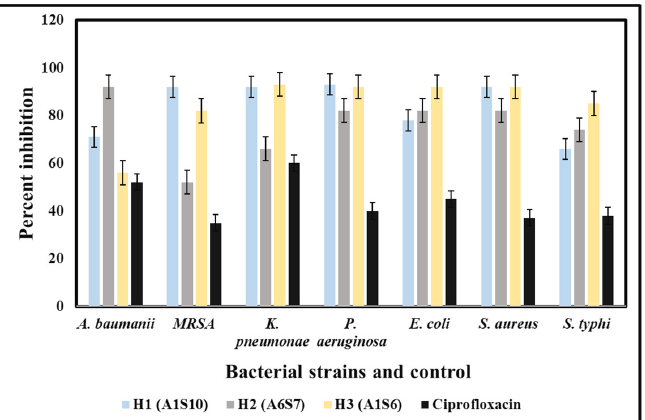
Figure 2. MIC results are shown by crude extracts of bacterial species against MDR strains with variable concentrations.